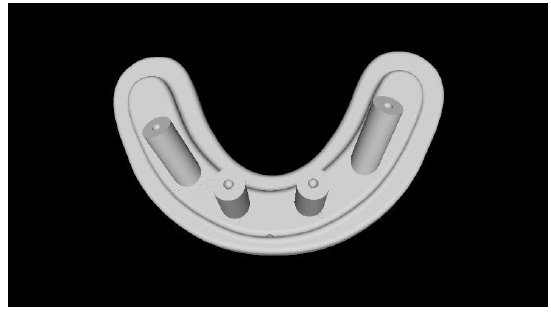
Figure 2. Virtual implant planning of six straight implants.